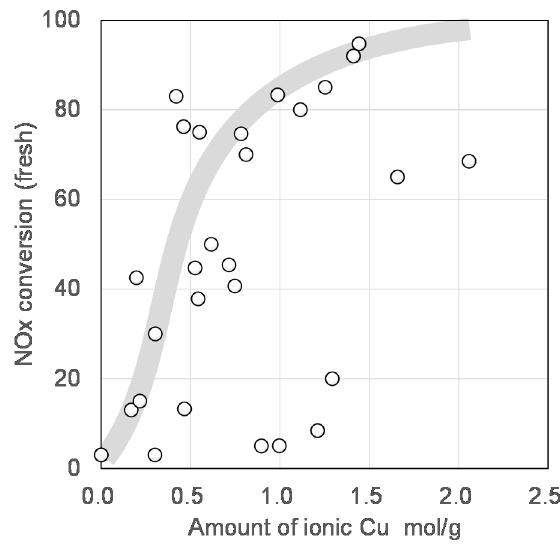
Figure 9. Catalytic performances for NH 3 -SCR at 200 ◦ C over Cu-zeolites with various frameworks, Si/Al ratios, and Cu contents. The plot data was based on the research [1].